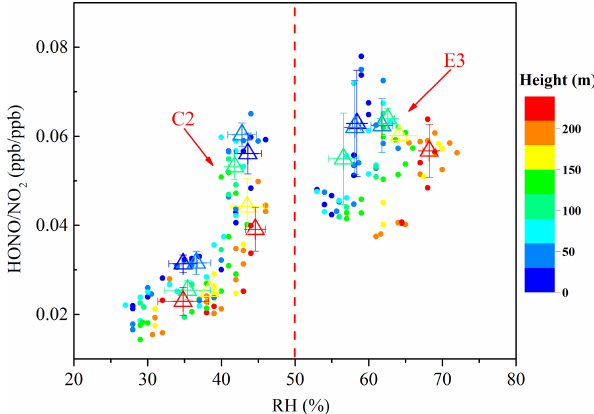
Figure 9. Scatter plot of HONO / NO 2 against RH of all vertical profiles during the clean episode (C2) and the haze episode (E3). The HONO / NO 2 ratio is color coded by the heights. Triangles are the average of the first five HONO / NO 2 values in each 10% RH interval at different height intervals (8–65, 65–120, 120–180, and